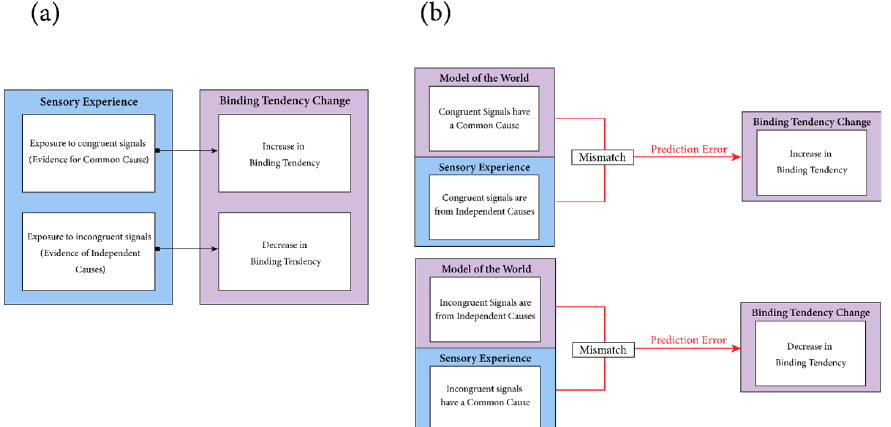
Figure 2. Learning mechanisms involved in binding tendency plasticity. Two possible learning mechanisms underlying the plasticity of binding tendency are illustrated. ( a ) The statistical learning mechanism: In this mechanism, every sensory event is informative and influential towards the tendency to bind. If an observer is frequently exposed to congruent audiovisual stimuli, each exposure increases the prior probability of a common cause by offering evidence of increased frequency of common-cause audiovisual stimuli. If an observer is frequently exposed to incongruent audiovisual stimuli, each exposure decreases the prior probability of a common cause. ( b ) The predictive coding mechanism. In this mechanism, only sensory events that contradict the internal generative model of the sensory environment will elicit updates in the prior probability of a common cause. For instance, if the internal generative model of the world expects that incongruent stimuli do not have a common cause, and an observer repeatedly experiences spatially incongruent but temporally congruent stimuli, these repeated sensory experiences contradict the internal model of the world and produce a model prediction-error signal. This results in a relaxation of binding tendency and an increased probability of common cause to account for the congruent stimuli that are nonetheless spatially discrepant. Adapted with permission from [28].